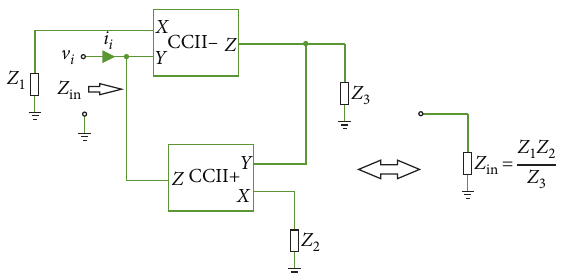
Figure 10: Lossless grounded active inductor circuit implemented by CCII.